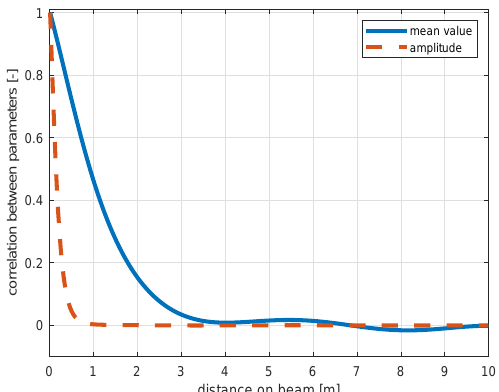
Figure 3. Correlation between estimated mean values and between estimated amplitudes at step